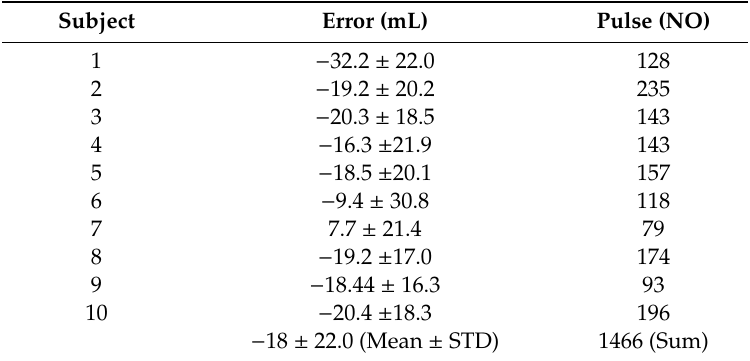
Table 2. The statistic error of stroke volumes (SVs) between the medis ® CS200 device and our ICG device using all testing PPG pulses.